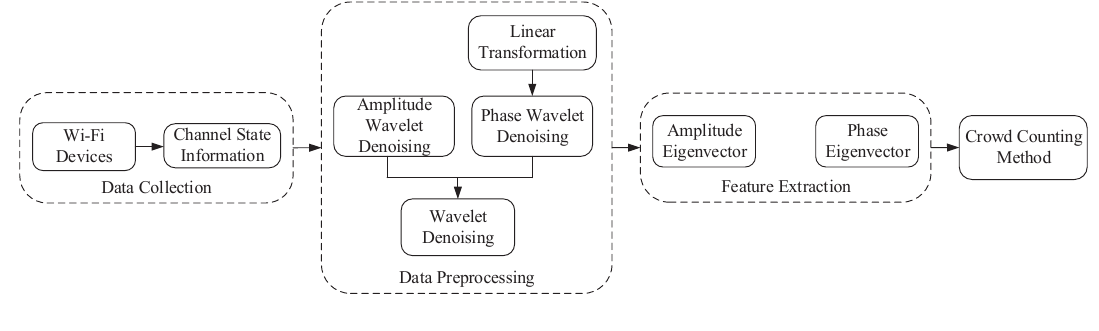
Figure 1. System